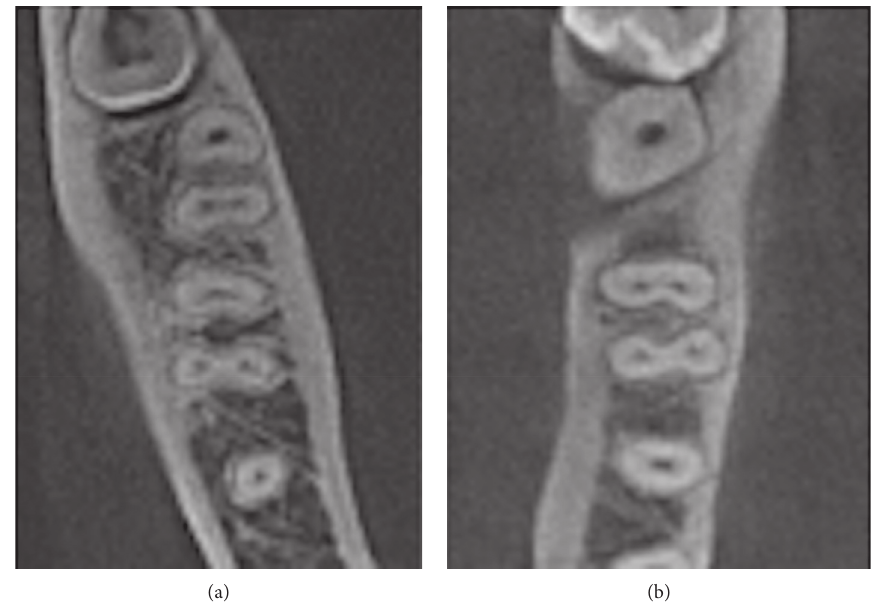
Figure 2: CBCT axial sections at midroots. (a) first and second mandibular molars with three canals and (b) first mandibular molar with four canals.